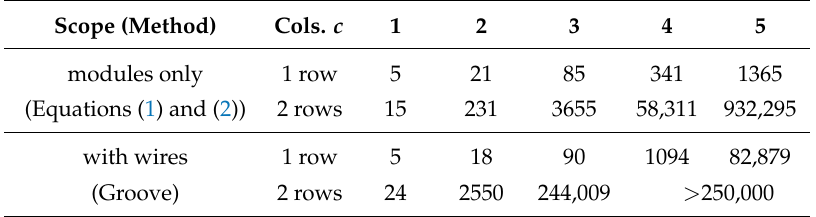
Table 4. Number of buildable systems: Top half: rough calculation of module combinations (without wiring). Lower half: Groove simulation results by considering module